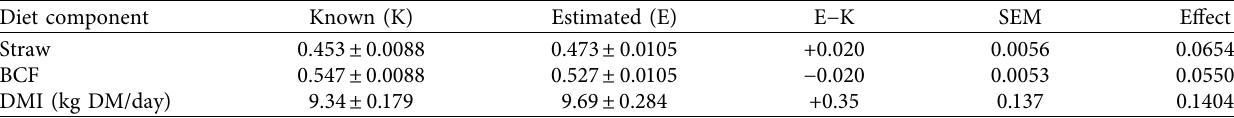
Figure 1: Evolution of the n-alkane faecal concentrations (mg/kg DM) of the bison along the experimental period. Table 3: Comparison of known and estimated measured proportions of dietary components and dry matter feed intake of bison fed on straw and beeswax labelled concentrate